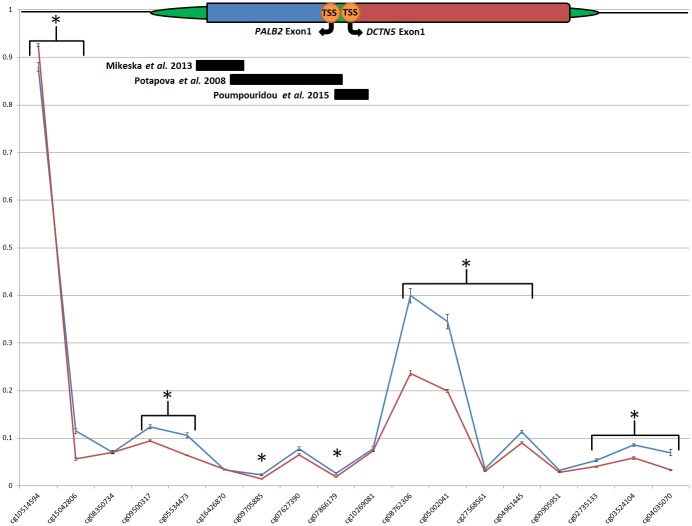
DNA methylation at the PALB2 promoter region.Plotted β-values for each sample at each CpG probe across PALB2 (chr16:23,649,887 –chr16:23,653,182). Red line indicates average β -value for blood-derived DNA samples. Blue line indicates average β-value for tumor-derived DNA samples. * indicates significant statistical difference (p<0.01). Solid black bars indicate regions previously screened for methylation. Gene region schematic denotes [CGI (CpG Island), TSS (Transcriptional Start Site)].